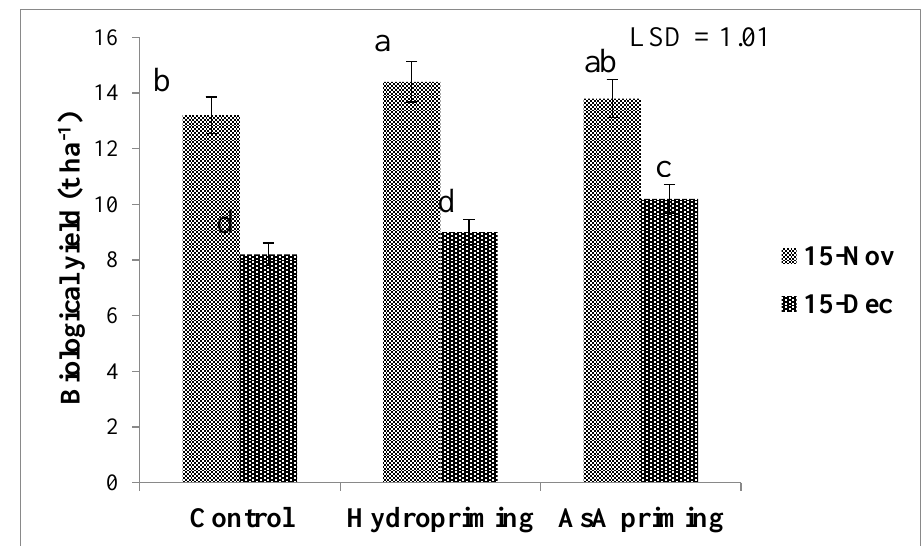
Figure 10. Interaction between priming techniques and sowing dates for biological yield during 2017. Means not sharing same letter (s) di ff er significantly at p ≤